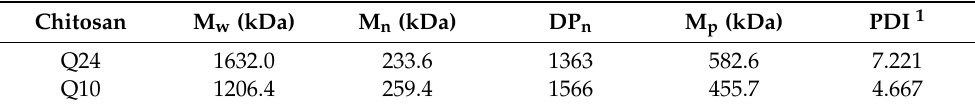
Table 2. MWs and DPs of chitosan Q24 and Q10, by GPC.